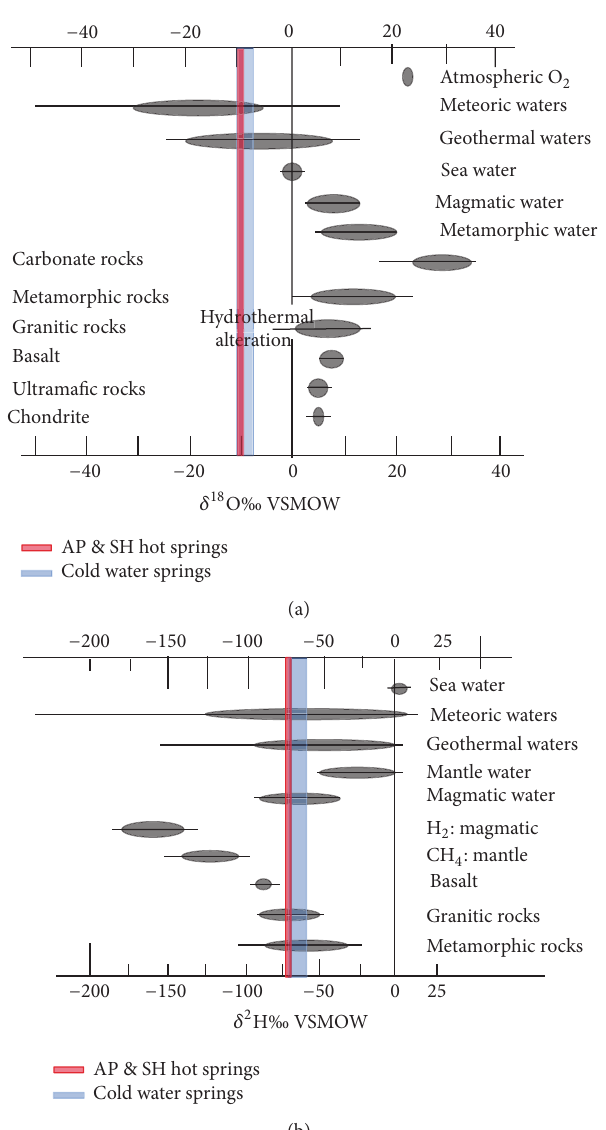
Figure 8: The range of 𝛿 18 O (a) and 𝛿 2 H (b) compositions in various crustal rock and water types [33] and the range of 𝛿 18 O and 𝛿 2 H in the AP hot spring and cold water springs in the study